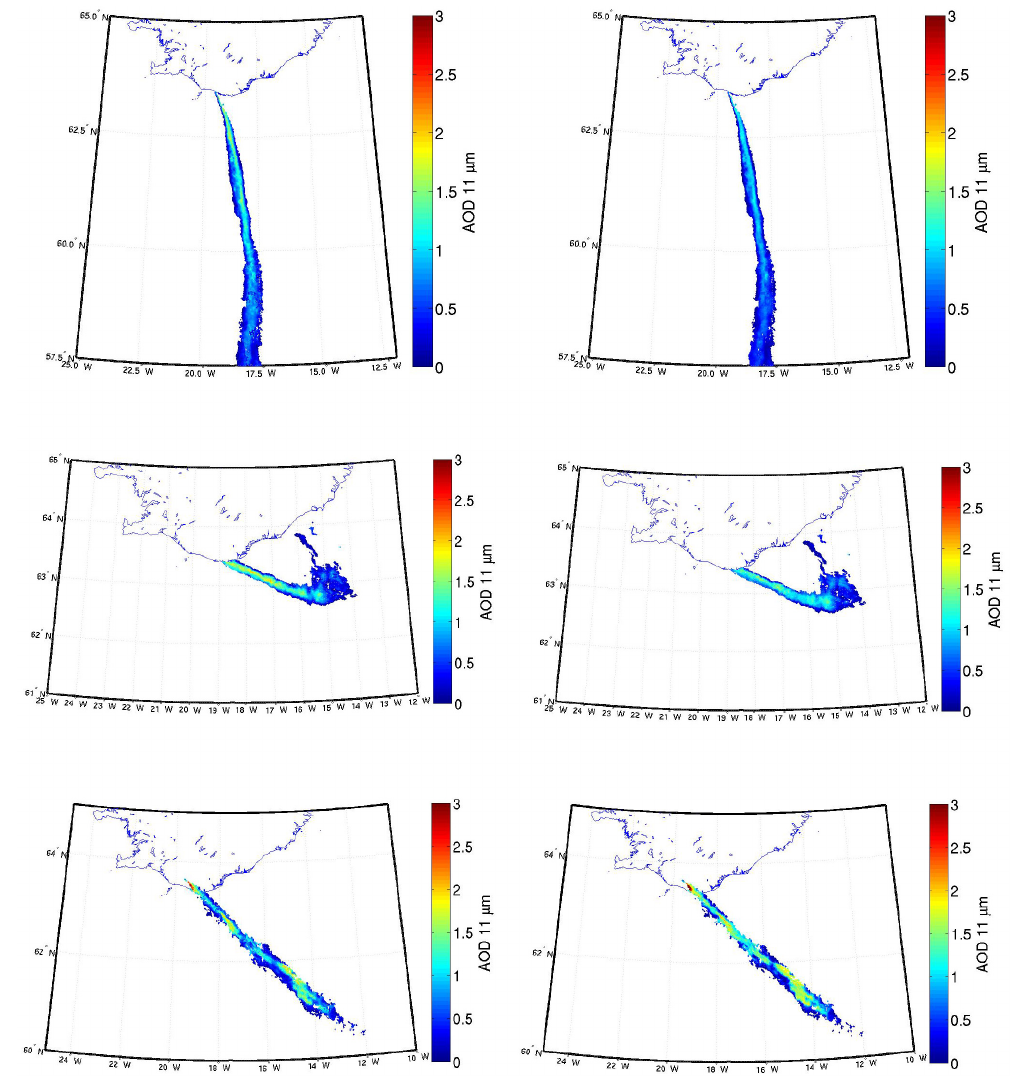
Figure 19. AOD maps: top, 11 May 2010; middle, 12 May 2010; bottom, 16 May 2010. Left: target retrieval; right: retrieval from pruned neural